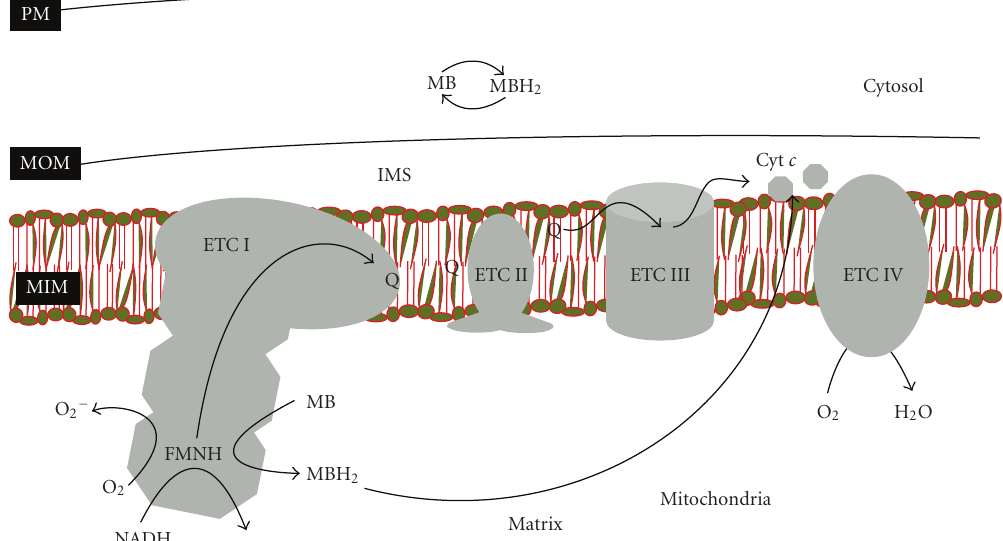
Figure 3: The proposed model for the interaction of methylene blue with specific mitochondrial and cellular components. ETC followed by roman number refers to the specific components of electron transport chain (ETC) of the mitochondria. MIM, MOM, and IMS refers to the mitochondrial inner membrane, mitochondrial outer membrane, and intermembrane space, respectively. MB and MBH 2 refer to oxidized and reduced forms of methylene blue, respectively. The four complexes are: complex I (ETC I), complex II (ETC II), complex III (ETC III), and complex IV (ETC IV) in addition to ATP synthase (i.e., complex V). The electron transfer through each one of the ETC starts at ETC I, which catalyzes two electrons oxidation of NADH and continues until water is formed on ETC IV. Coenzyme Q serves as low-molecular weight electron carrier from ETCs I and II to III. Cytochrome c (cyt c ) serves as electron carrier from ETC III to ETC IV. Production of superoxide radical from complex I is proposed to be prevented by MB, which serves as electron carrier that competes with molecular oxygen on the electrons “leaking” from complex I. During this process MB is converted to MBH 2 . Then MBH 2 , a reduce MB, carries the electrons to cytochrome c , which is then oxidized by ETC IV